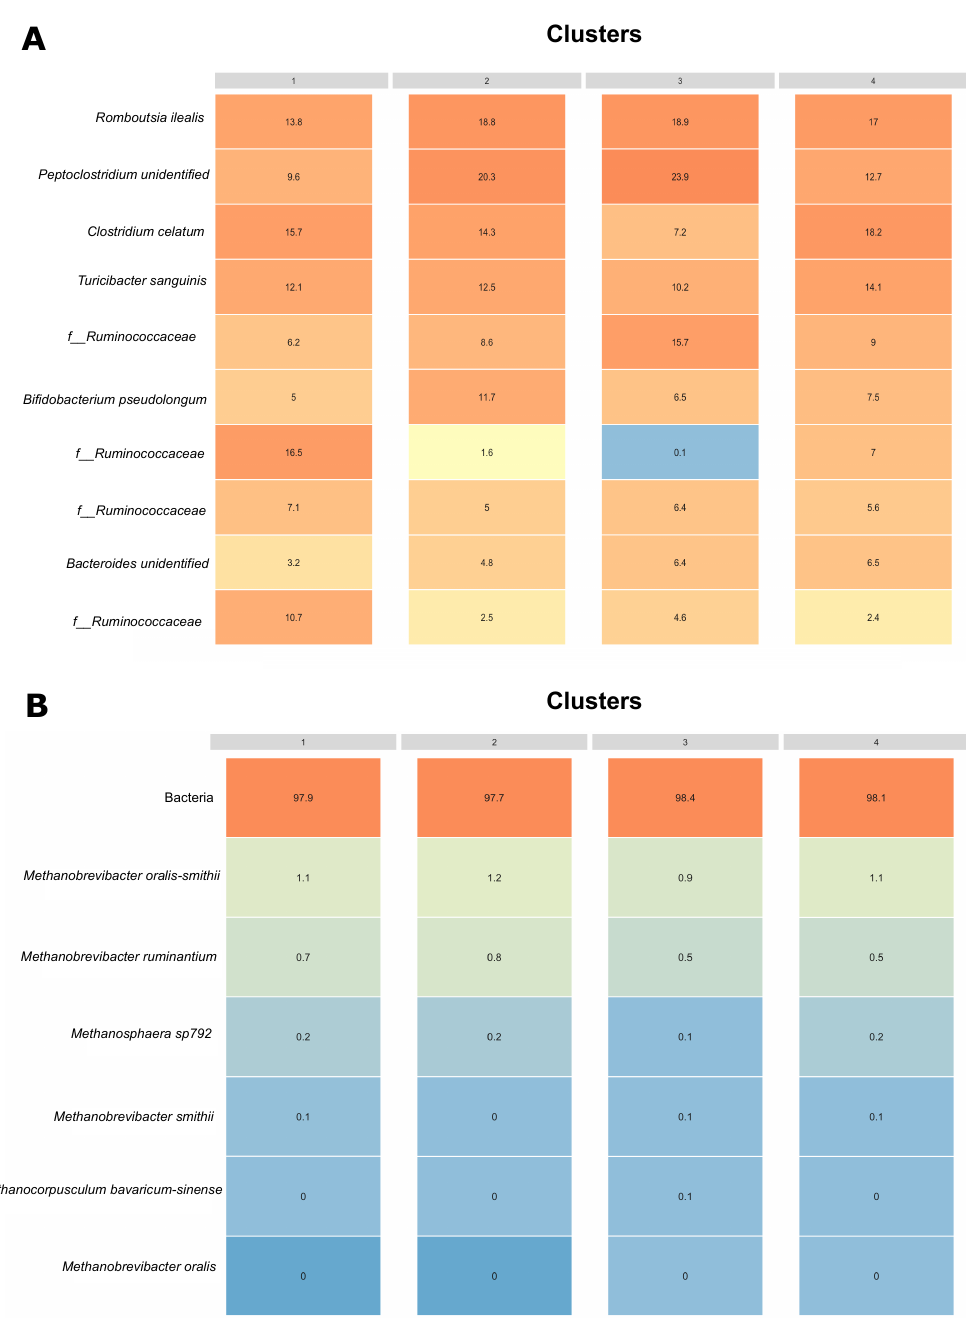
Figure 5. Relative abundance heatmap across clusters. Mean relative abundance for the most predominant bacterial species across clusters is indicated by the values in the tiles ( A ). Mean relative abundance of all archaea organisms at the species level across clusters is indicated by the values in the tiles ( B ). The color gradient indicates different levels in relative